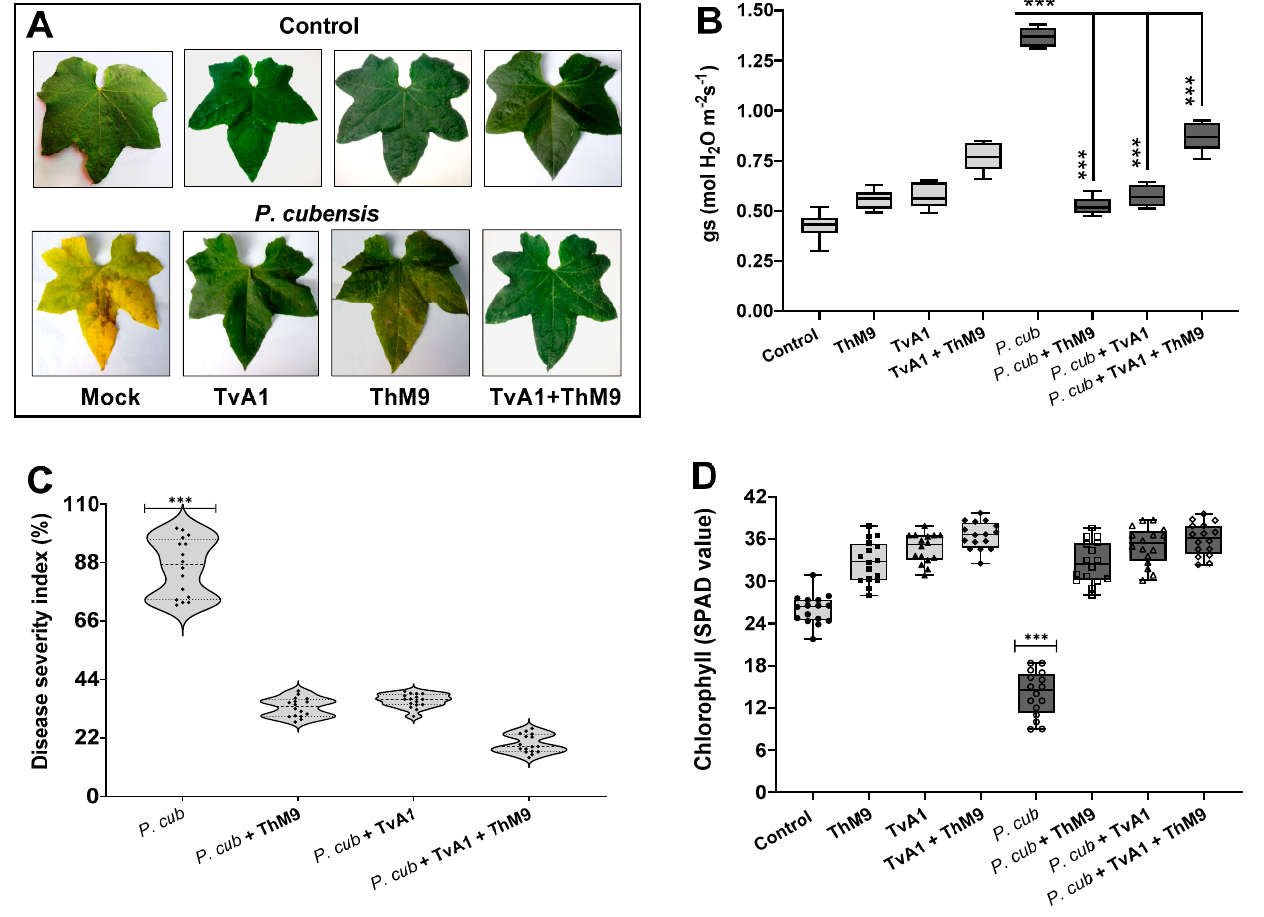
Figure 5. Effect of the fungal isolates (ThM9 and TvA1) and pathogen ( P. cubensis ) co-inoculation in luffa detached whole leaf bioassay. ( A ) Visualization of disease severity on luffa detached the whole leaf upon co-inoculation with fungal endophytes and pathogen. ( B ) Transpiration rate. ( C ) Disease severity index (%). ( D ) Chlorophyll content. Quantitative data represent the means ± SD (n = 12) of three independent experiments. The asterisks indicate represents a significant difference between treated samples compared to control (*** p ≤ 0.005).